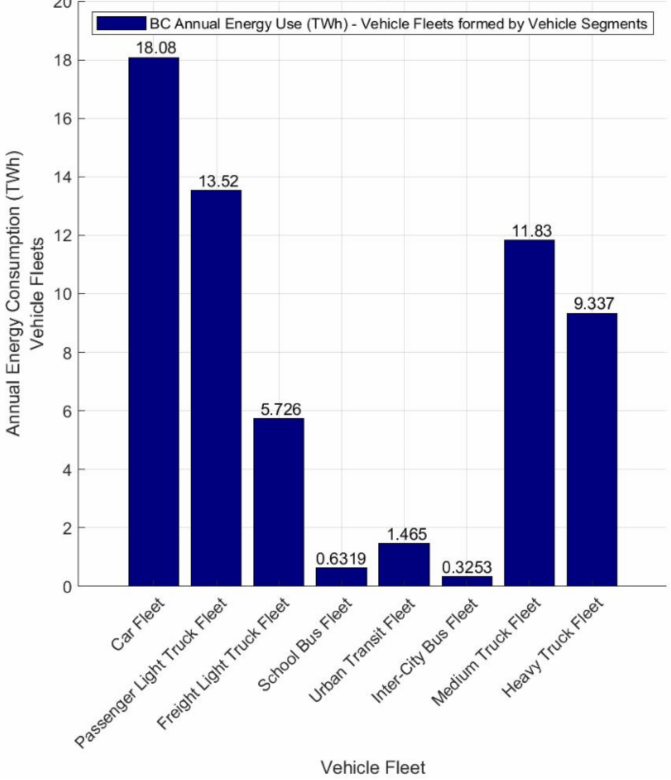
Figure 7. B.C. road transportation annual energy use for vehicle fleets in (TWh), B.C. statistical data from